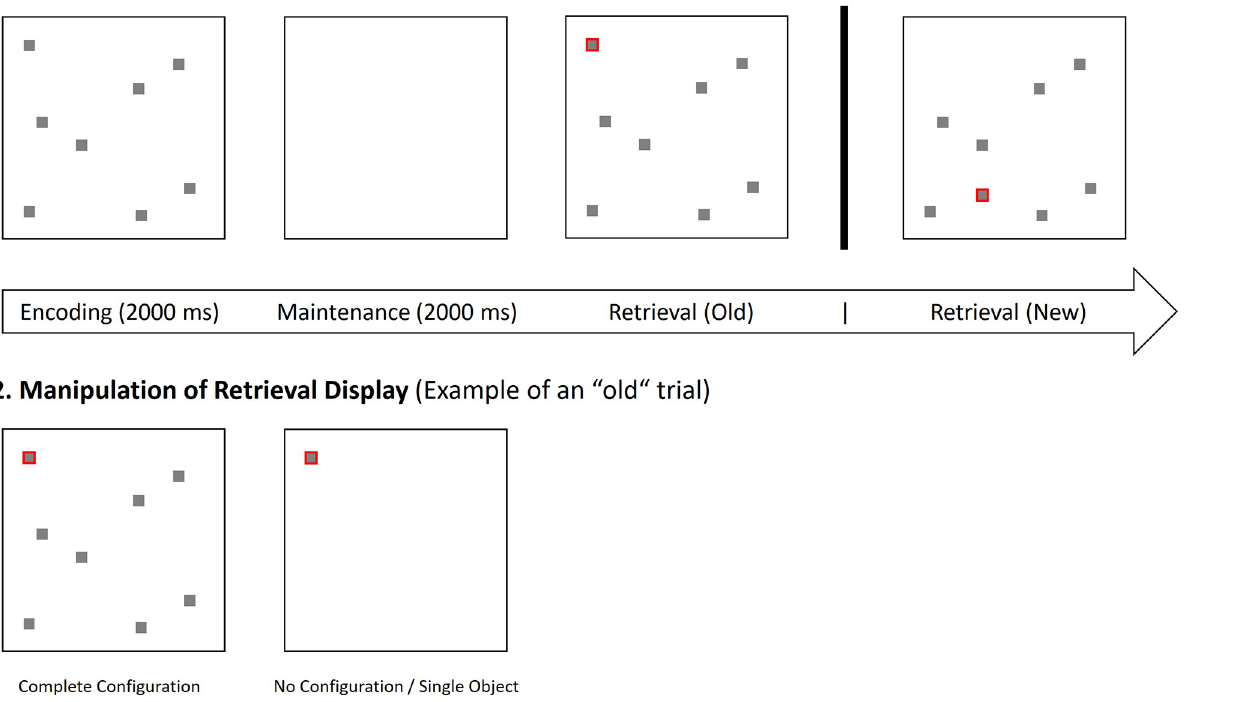
PLOS ONE | https://doi.org/10.1371/journal.pone.0281445 February 9,